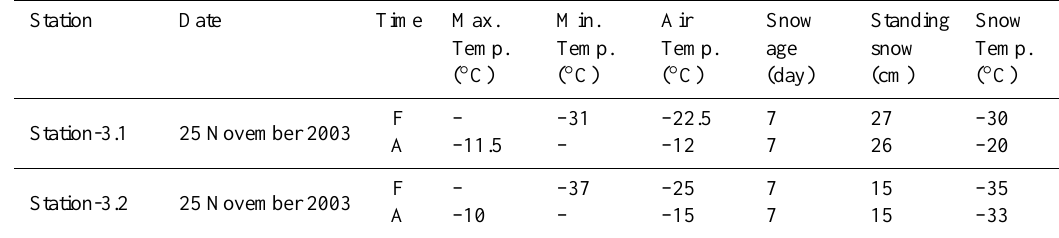
Table 7. Snow meteorological data recorded at 08:30 (F) and 17:30 (A) local time at two different stations of upper Himalaya. Station